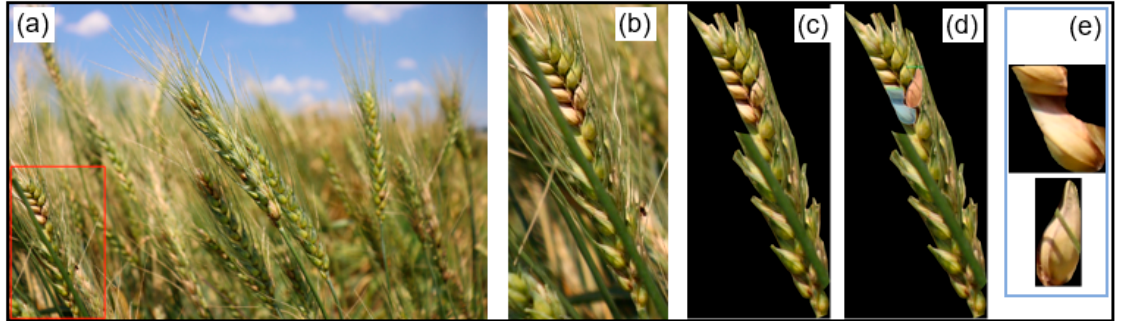
Figure 9. The process of disease detection for an entire wheat spike partially occluded by the peduncle (neck) of another plant; ( a ) a selected example of an original image with multiple wheat spikes; ( b ) a zoom-in view of a spike occluded by a peduncle; ( c ) Mask-RCNN for wheat spike detection; ( d ) Mask-RCNN for disease area identification; ( e ) the segmentation result of diseased spikelets.